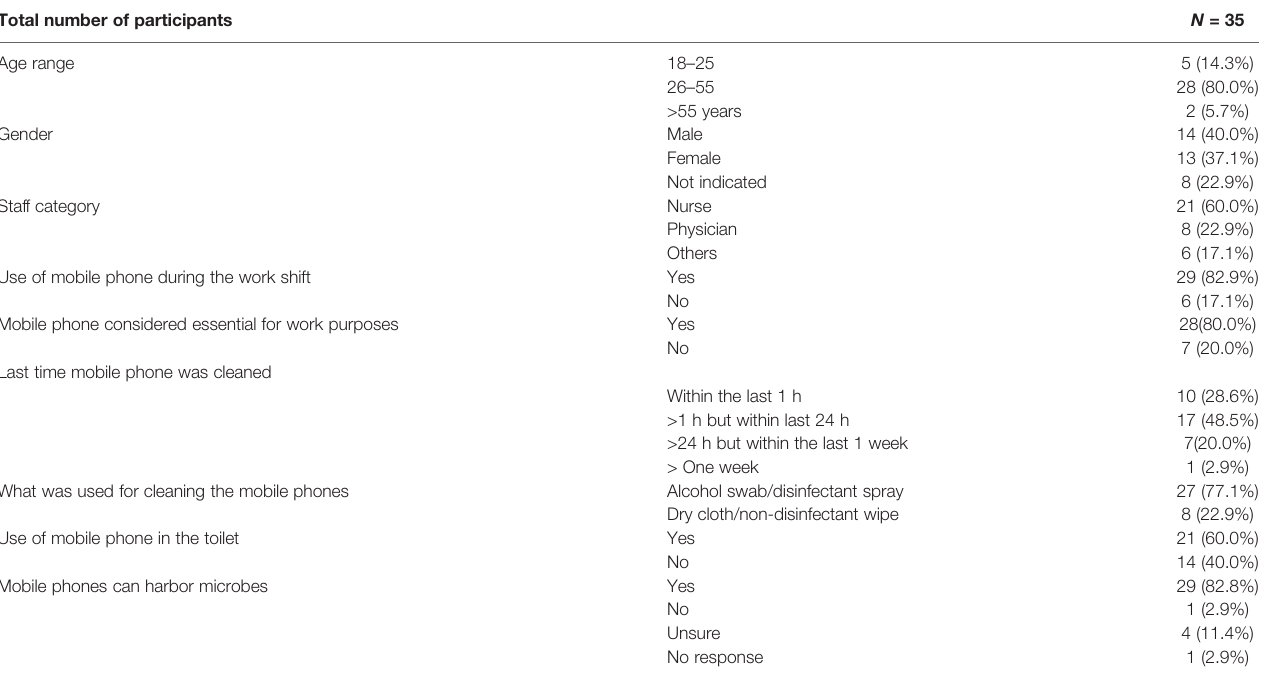
TABLE 1 | Demographic pro fi le and the mobile phone utilization and cleaning practices of participants. Total number of participants Age